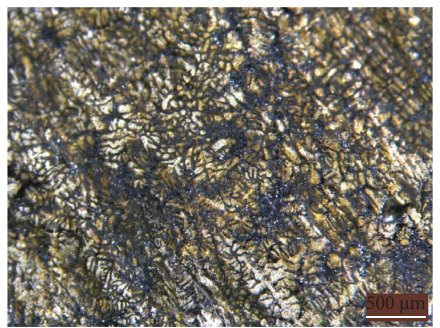
Figure 10: Microstructure at optimum corrosion